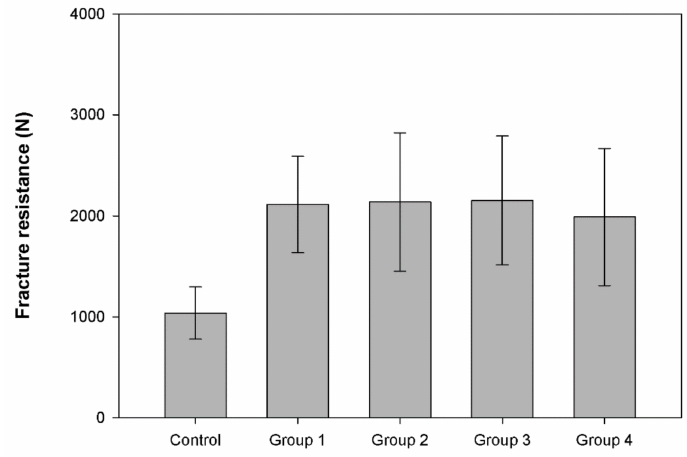
Figure 3. Fracture resistance mean values (N) and standard deviations of surviving test